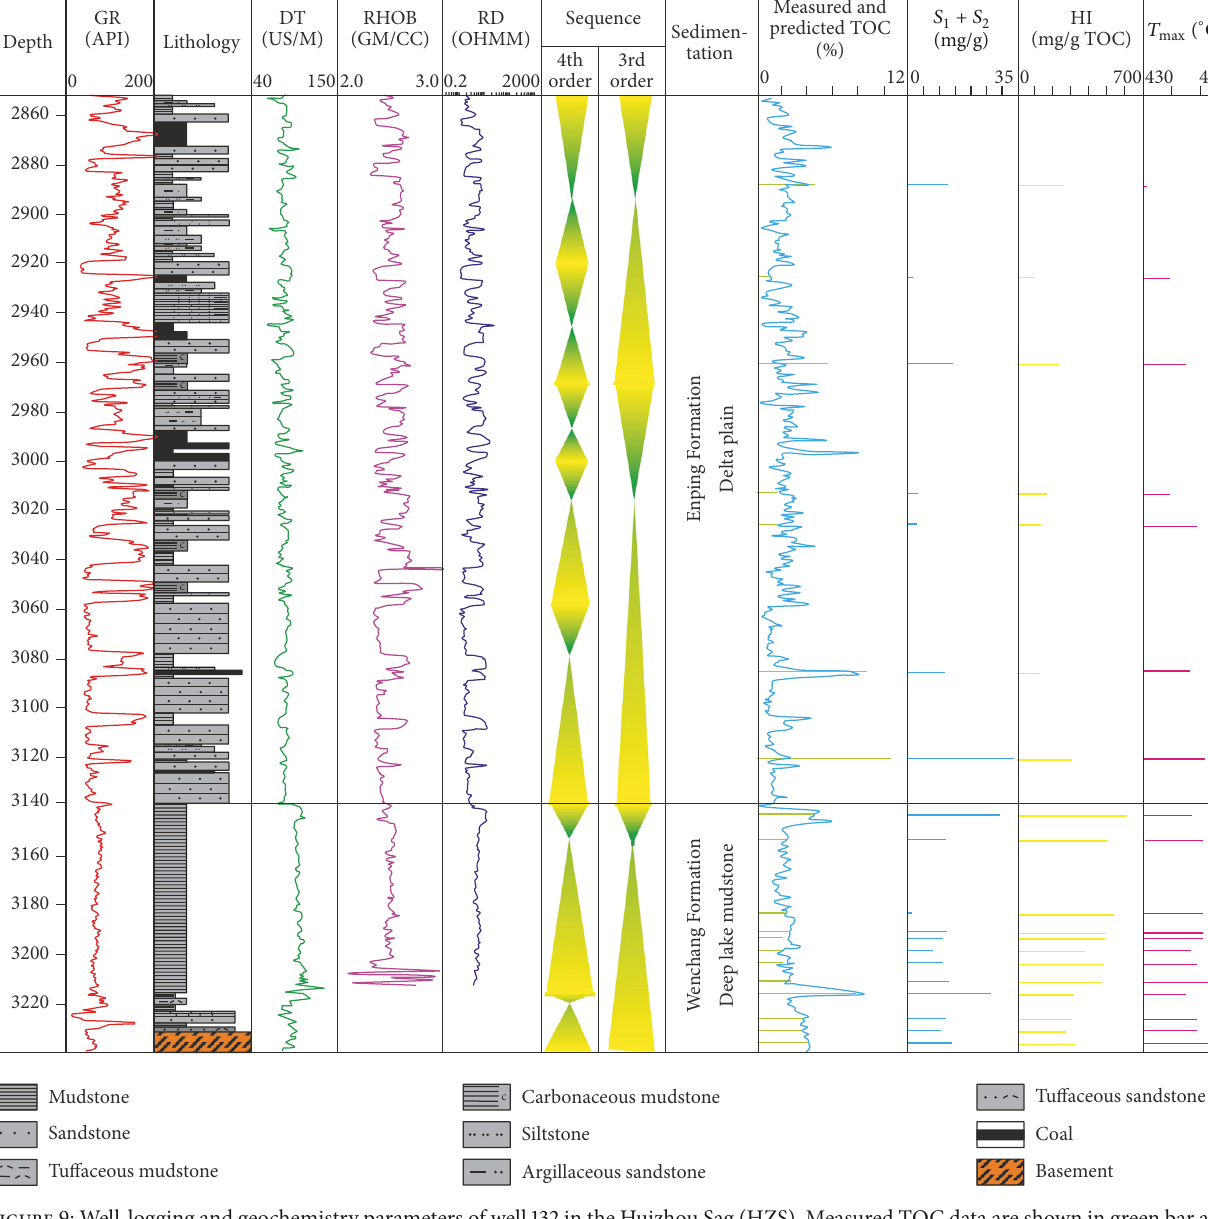
Figure 9: Well-logging and geochemistry parameters of well 132 in the Huizhou Sag (HZS). Measured TOC data are shown in green bar and the predicted TOC data using well-log curves calibrated by measured data are shown in blue curve.